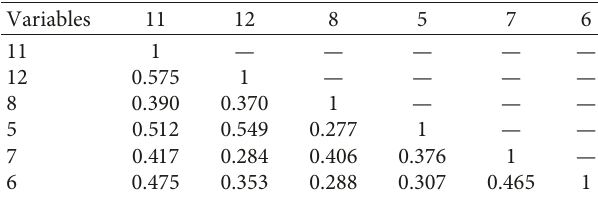
Table 6: Pearson correlation coefficient matrix for the variables in factor